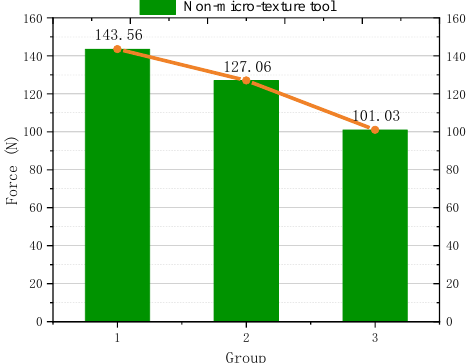
Figure 2. Cutting force of non-micro–textured tool.